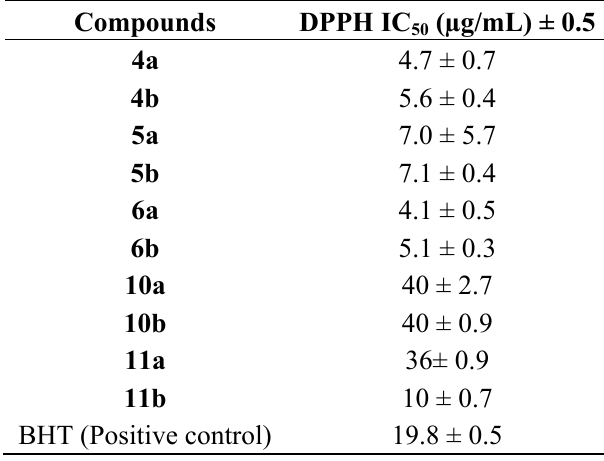
Figure 1. The graphical representation of antioxidant activities